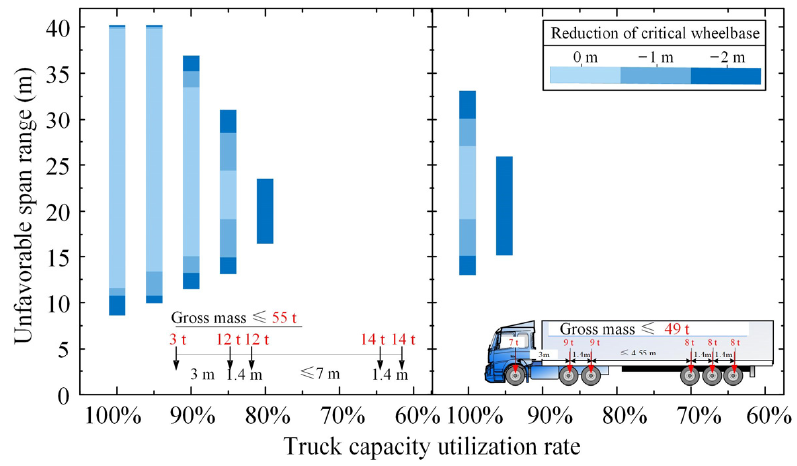
Figure 8. Unfavorable span ranges of Grade-II simply supported bridges under the action of ATP loads consisting of design truck loads and six-axle truck loads.